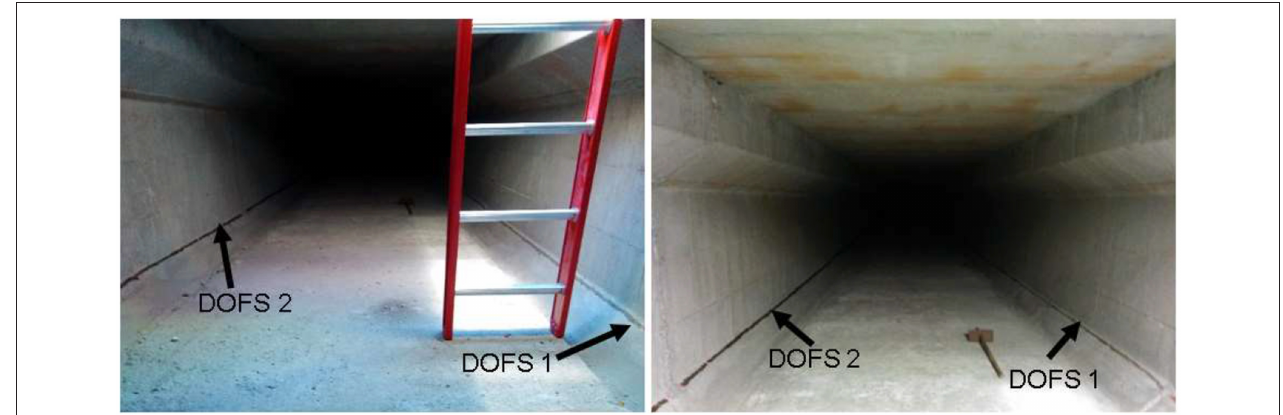
FIGURE 16 | Instrumented DOFS in interior of box-girder beam at Sarajevo